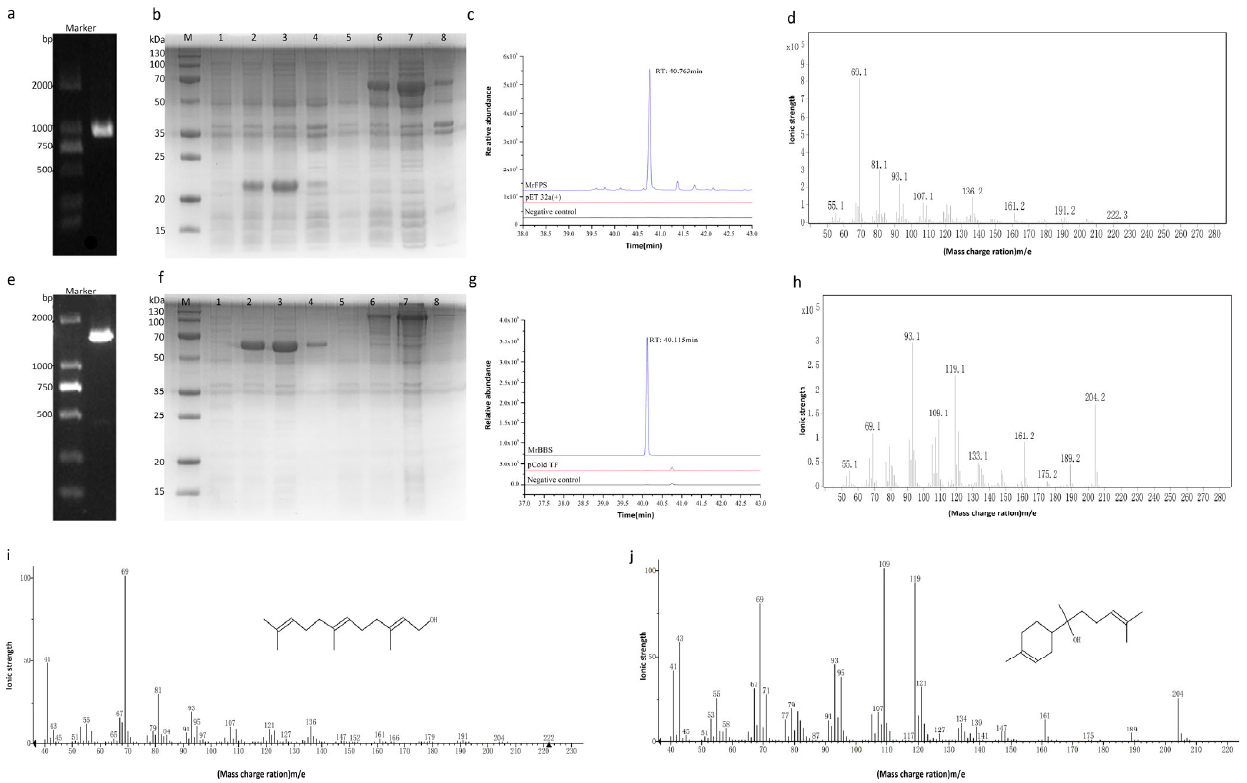
Figure 1. Gene cloning and SDS ‐ PAGE analysis of MrFPS and MrBBS expressed in E. coli, and en ‐